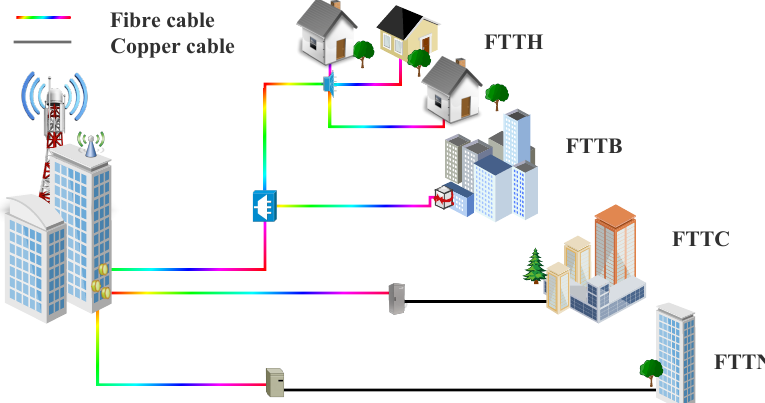
Figure 4. A typical FTTx